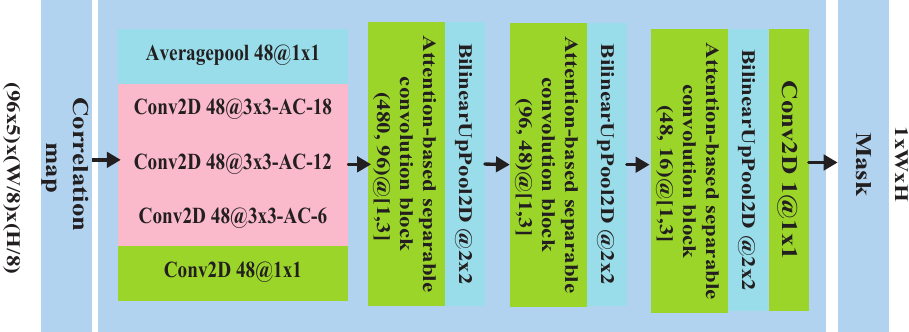
Figure 4. Parameter settings of mask generator architecture. “3 × 3” and “[1, 3]” indicate the kernel size used in convolution layers. “AC” means the atrous convolution, and “6”, “12”, “18” stand for the r s of atrous convolution. “480”, “96”, “48”, “16” represent the input or output channels of each